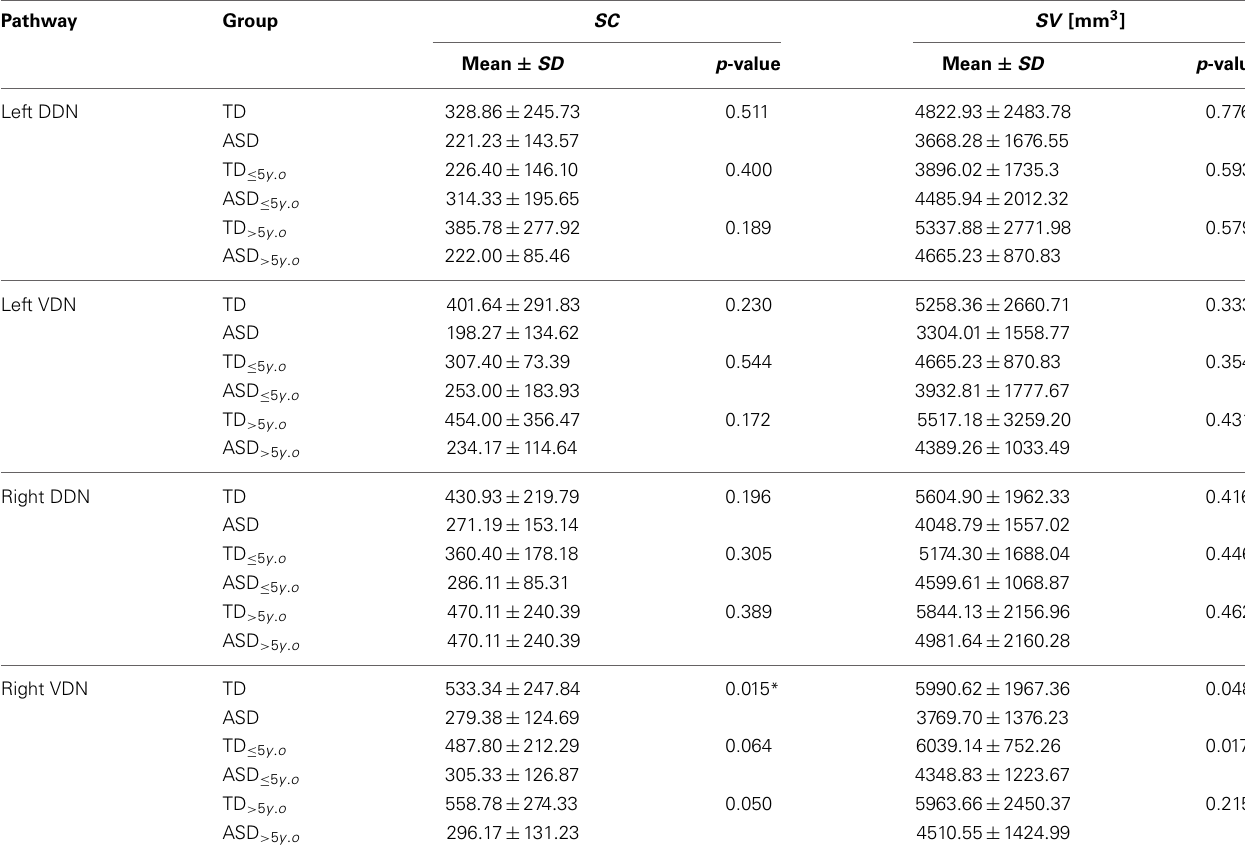
Table 2 | Streamline count (SC) and streamline volume (SV) of the pathways connecting cerebellar cortex to the dentate nuclei.